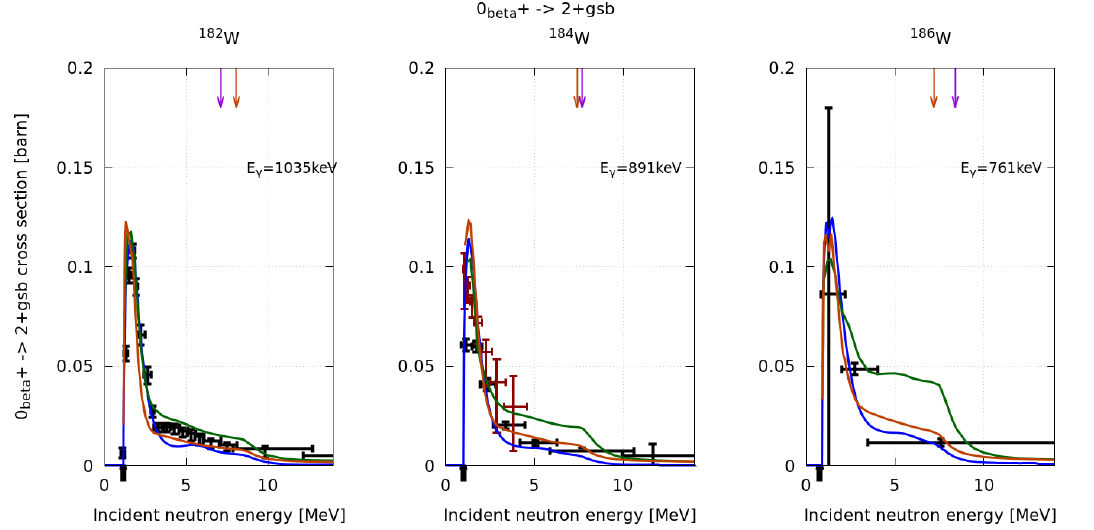
Figure 4. Same as figure 1, for the 0 + the nat W dataset only for 184